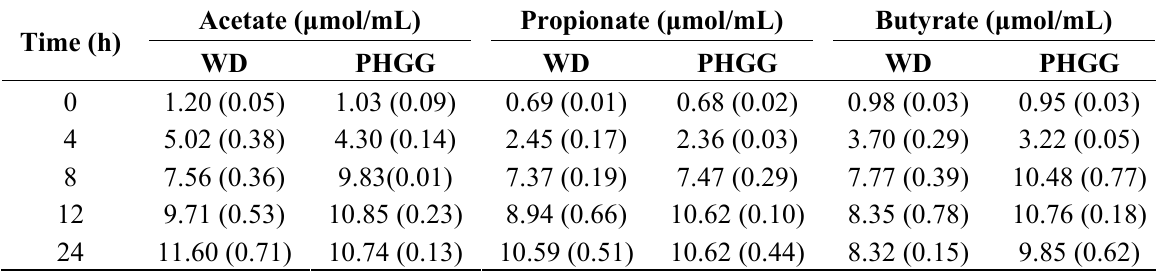
Table 2. Short Chain Fatty Acids (SCFAs) of Exposed Human Fecal Inoculum across 24 h of Analysis.